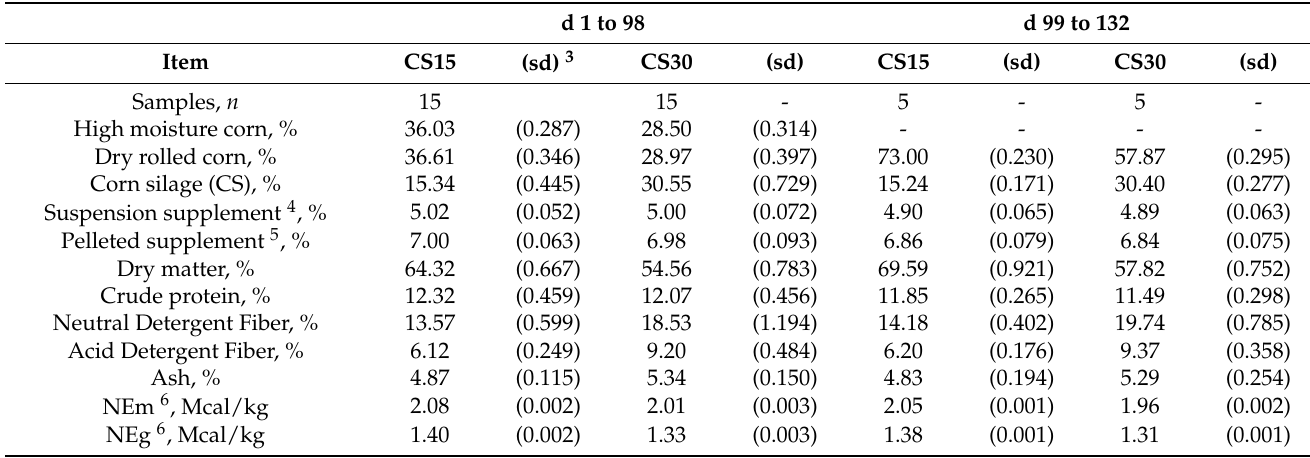
Table 1. Actual diet formulation and composition based upon weekly DM and nutrient composition determinations for 15% corn silage (CS15) and 30% corn silage (CS30) 1,2